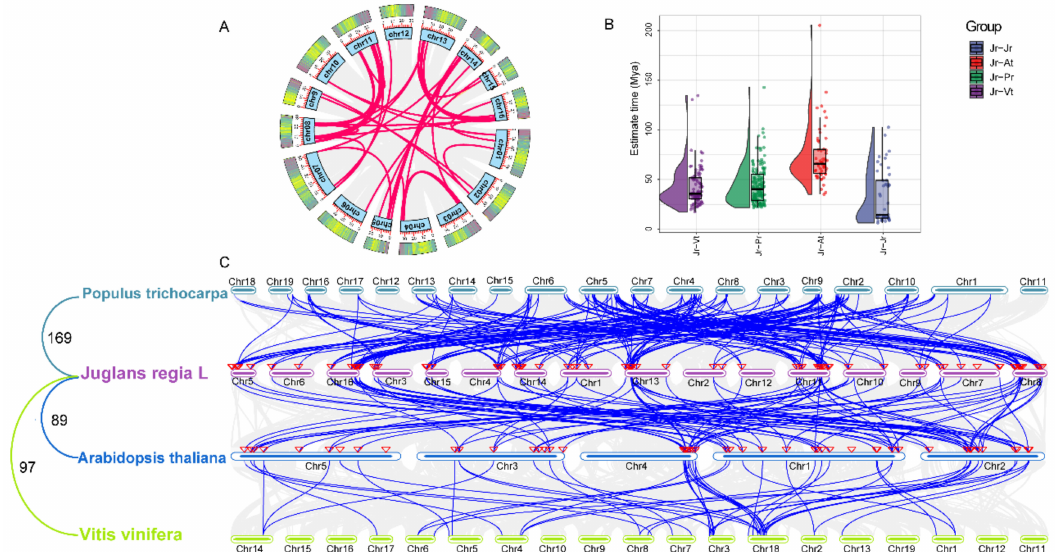
Figure 3. ( A ) Distribution and segmental duplication of bZIP genes in walnut. The blue panel showed the 16 chromosomes using a circle, red lines connecting homologous genes; ( B , C ) analysis of the Arabidopsis, Populus trichocarpa, grape, and walnut bZIP families. The gray lines in the background indicate the collinear blocks between walnut and other plant genomes, while the blue lines highlight the syntenic bZIP gene pairs. The chromosome number is shown at the top of every